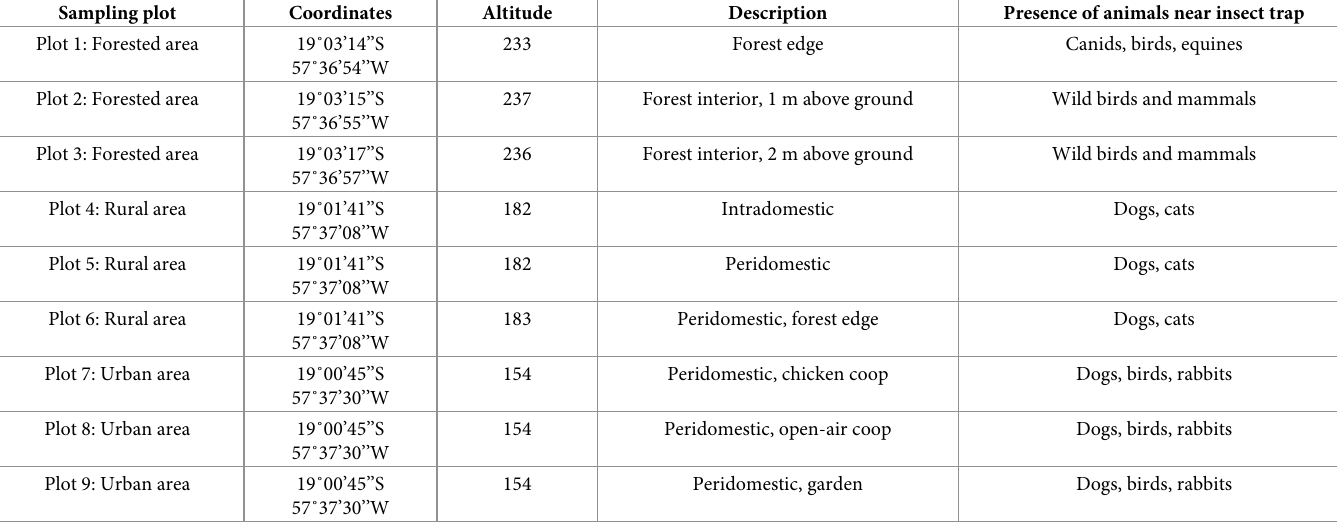
Table 1. Coordinates and description of sampling plots (forested, rural, and urban areas). Corumba´, Mato Grosso do Sul, Brazil. May 2015 to April 2017. Sampling